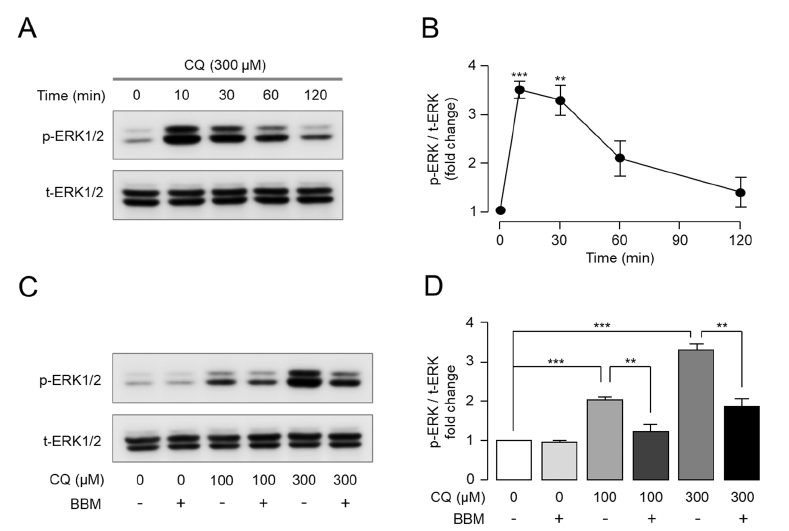
Figure 3. Effects of berbamine on the activity of other pruritogenic GPCRs: ( A , B ) Effect of berbamine on histamine 1 receptor (H1R) and histamine 4 receptor (H4R). H1R- and H4R-expressing HEK293T cells were pretreated with 30 μ M BBM for 10 min prior to 100 μ M histamine treatment. H1R and H4R were inhibited by 30 μ M alcaftadine (ALC) and JNJ-7777120 (JNJ), respectively. ( C ) Effect of berbamine on PAR2. HT29 cells were pretreated with BBM for 10 min prior to 30 μ M PAR2-AP treatment. PAR2 was inhibited by 30 μ M punicalagin (PCG). ( D ) Effect of berbamine on MrgprC11. MrgprC11-expressing HEK293T cells were pretreated with BBM for 10 min prior to 100 µ M PAR2-AP treatment. ( E ) Effect of berbamine on MrgprX4. MrgprX4-expressing HEK293T cells were pretreated with BBM for 10 min prior to 80 µ M DCA treatment. ( F ) Effect of berbamine on TGR5. TGR5 activity was measured using a YFP fluorescence quenching assay. CHO-K1 cells coexpressing TGR5 and a halide sensor YFP were pretreated with BBM and 80 µ M DCA for 10 min prior to I - treatment. Results were summarized as means ± S.E. ( n = 6). NTC, nontransfected cells. 2.4. Berbamine Inhibits CQ-Induced ERK1/2 Phosphorylation through MrgprX1 MrgprX1 activation increased the phosphorylation of extracellular signal-regulated kinase (ERK) 1/2 in HEK293T cells expressing MrgprX1 [17]. Thus, we investigated whether CQ induced the phosphorylation of ERK1/2 in HEK-MrgprX1 cells. Strong and significant ERK1/2 phosphorylation was observed following CQ application, and ERK1/2 phosphorylation peaked 10 min after CQ treatment (Figure 4A,B). Interestingly, berbamine significantly reduced CQ-induced ERK1/2 phosphorylation (Figure 4C,D).